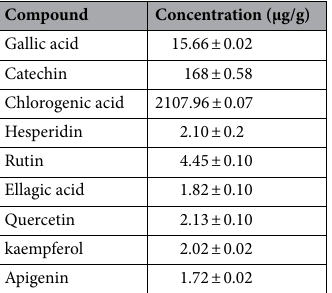
Table 1. Phenolic and flavonoid contents of D. caffra fruit extract.